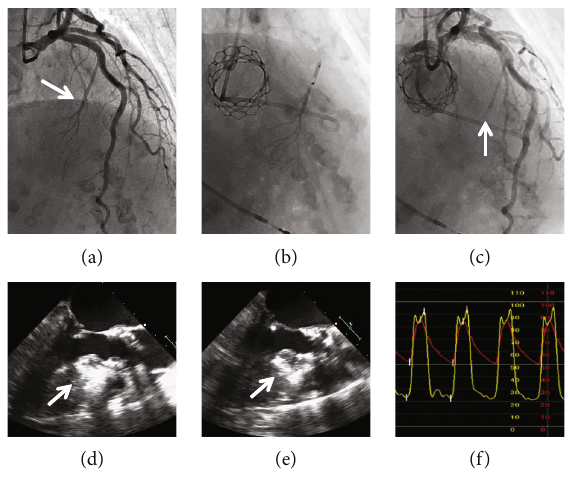
Figure 1: (a) The fi rst septal branch was con fi rmed beforehand. (b) Tip injection into the septal branch using a 2mm balloon. (c) Total occlusion of the septal branch was con fi rmed after alcohol injection. (d) Transesophageal echocardiography con fi rmed the perfusion area of the septal branch as a bright area by contrast injection. (e) Alcohol was administered into the septal branch. (f) Finally, pressure gradient at the left ventricular out fl ow tract was